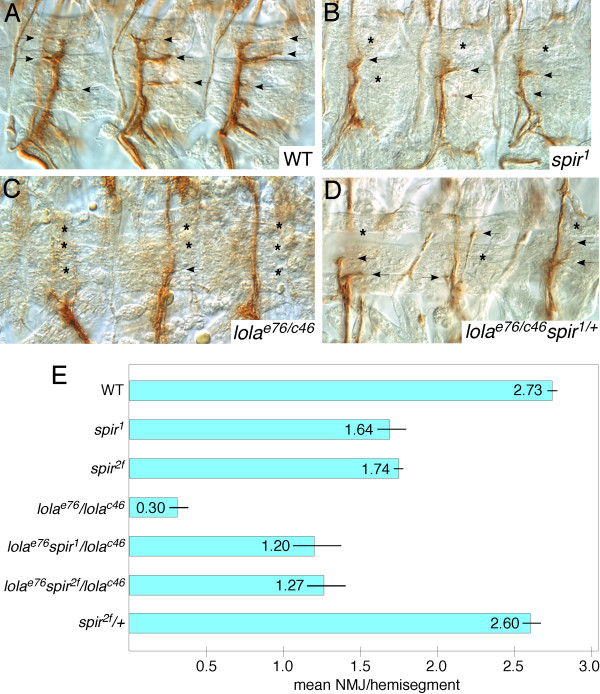
Genetic interaction of lola and spire mutations. Stage 17 embryos of the indicated genotypes were fixed and stained with anti-Fasciclin 2 to label ISNb motor axons, and visualized by peroxidase histochemistry. Three representative hemisegments are shown in each panel. (A) Wild type (WT). ISNb forms three neuromuscular junctions (NMJs) to ventral longitudinal muscles per hemisegment (arrows). (B) spir1 homozygous mutant. NMJs are indicated with arrows, positions where NMJs are missing are highlighted with asterisks. (C) lolae76/lolac46 null mutant. (D) lolae76spir1/lolac46 embryo. Note partial restoration of NMJs. (E) Quantification of NMJ number in embryos of the indicated genotypes. Average number of NMJs per hemisegment is plotted as blue bars. Thin lines indicate standard error of the mean of three experiments (N = approximately 200 hemisegments per dataset).